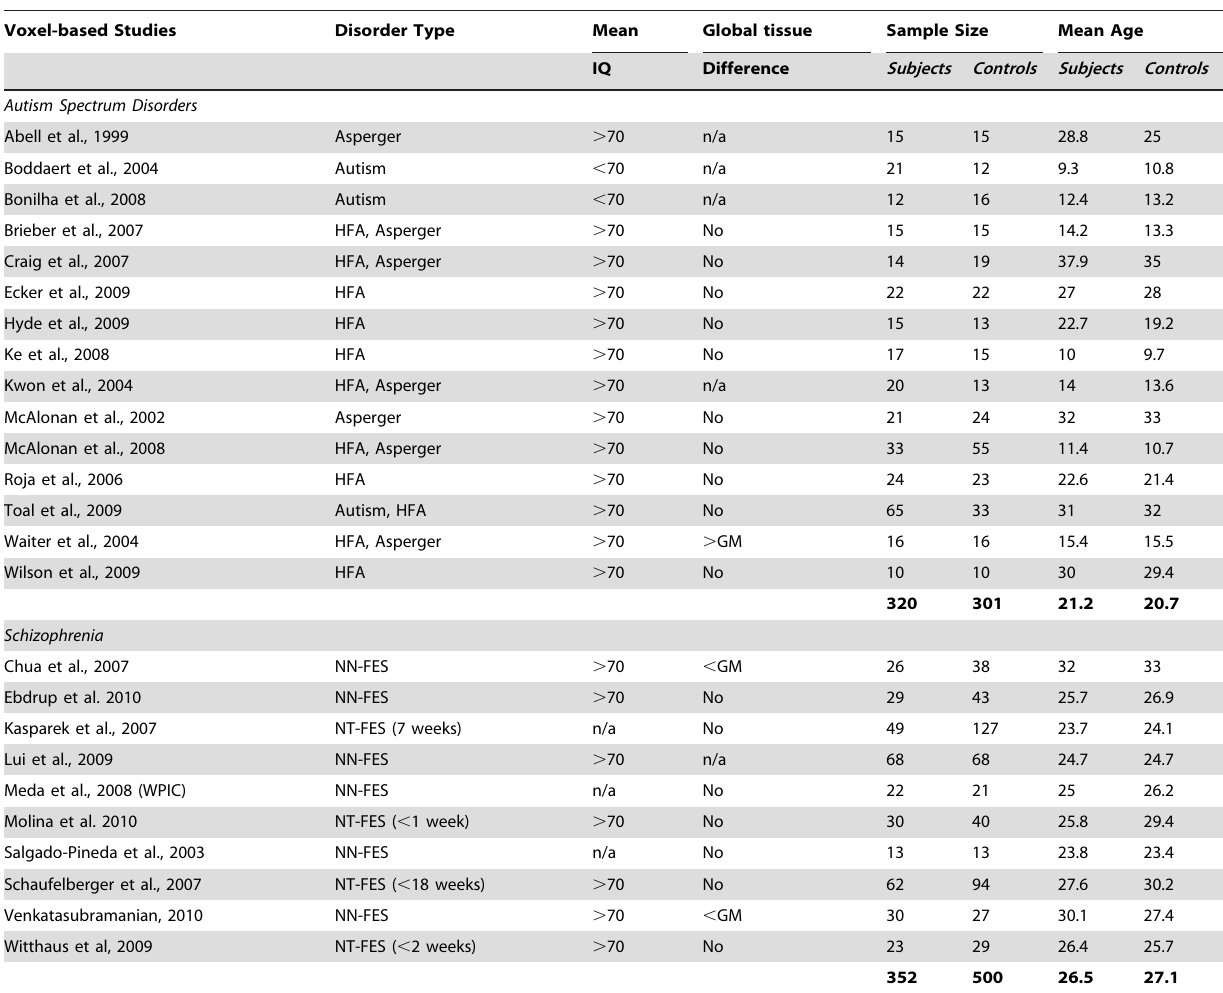
Table 1. Voxel-based studies included in the